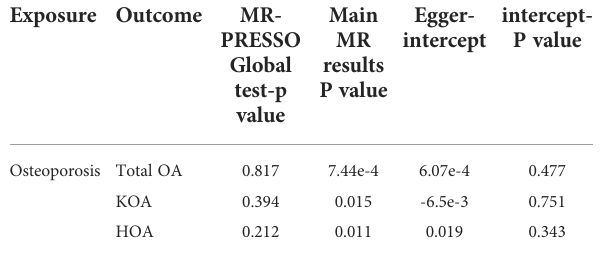
TABLE 2 MR-PRESSO analysis and MR-Egger intercept of osteoporosis causally linked to osteoarthritis.